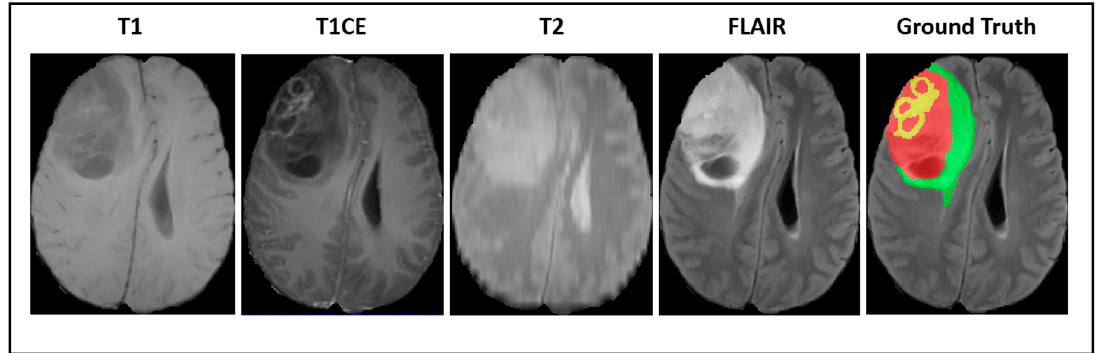
Figure 2. A visualization of Brain Tumor Segmentation Challenge (BraTS) datasets with a tumor mask where green illustrates the edema, yellow illustrates the enhancing tumor, and red illustrates the necrotic area.